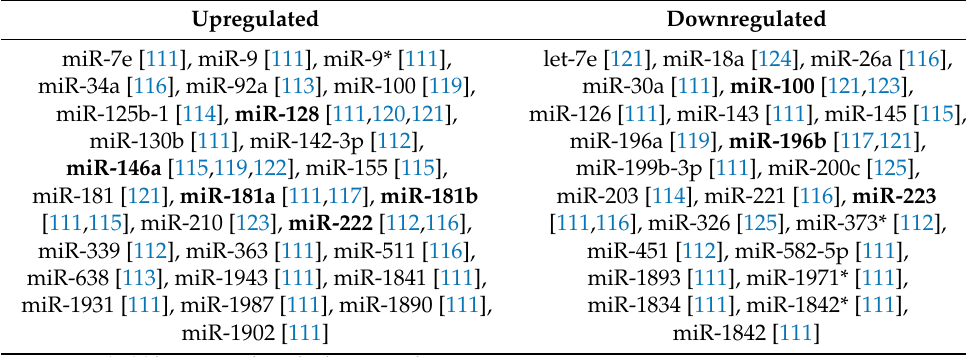
Table 1. Abnormally expressed miRNAs in acute lymphoblastic leukemia patients compared to healthy individuals. Upregulated